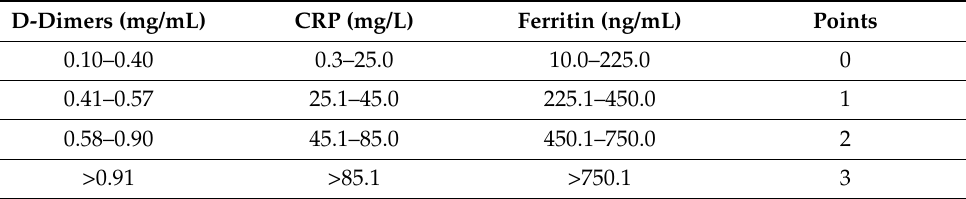
Table 1. Modified SCOPE index (three-parameter) calculation without IL-6.